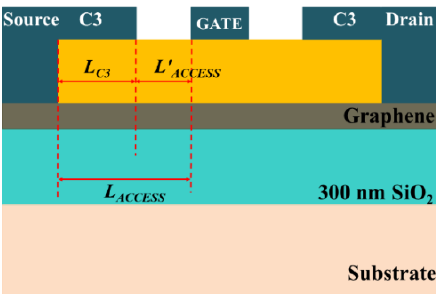
Figure 9. Schematic of the proposed GFET (not to scale).